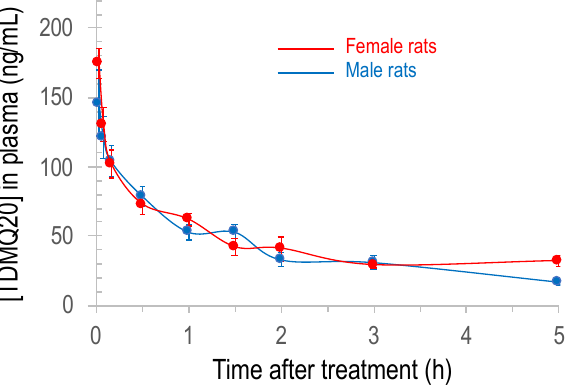
Figure 2. Plot of the concentration of TDMQ20 detected by LC–MS/MS in rat plasma as a function of time after intravenous administration of the drug (2.5 mg/kg). Mean values of 6 female and 6 male rats (red and blue traces, respectively), bars stand for SEM.